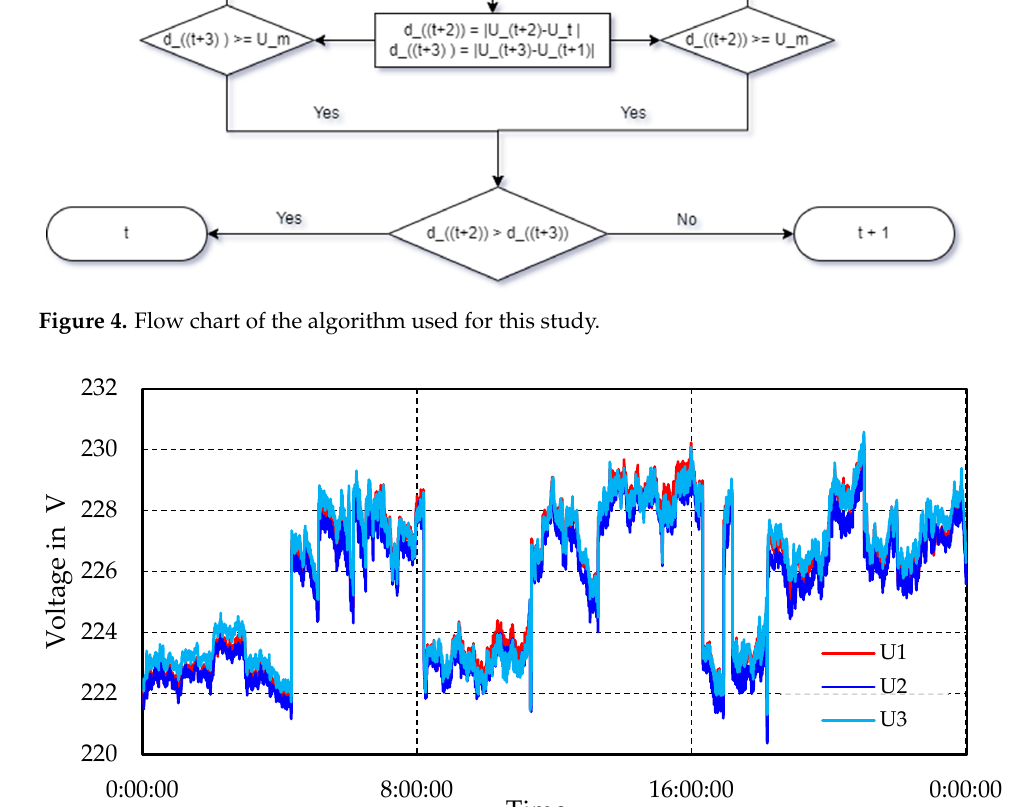
Figure 5. Voltage pro fi les on 20 January 2020.